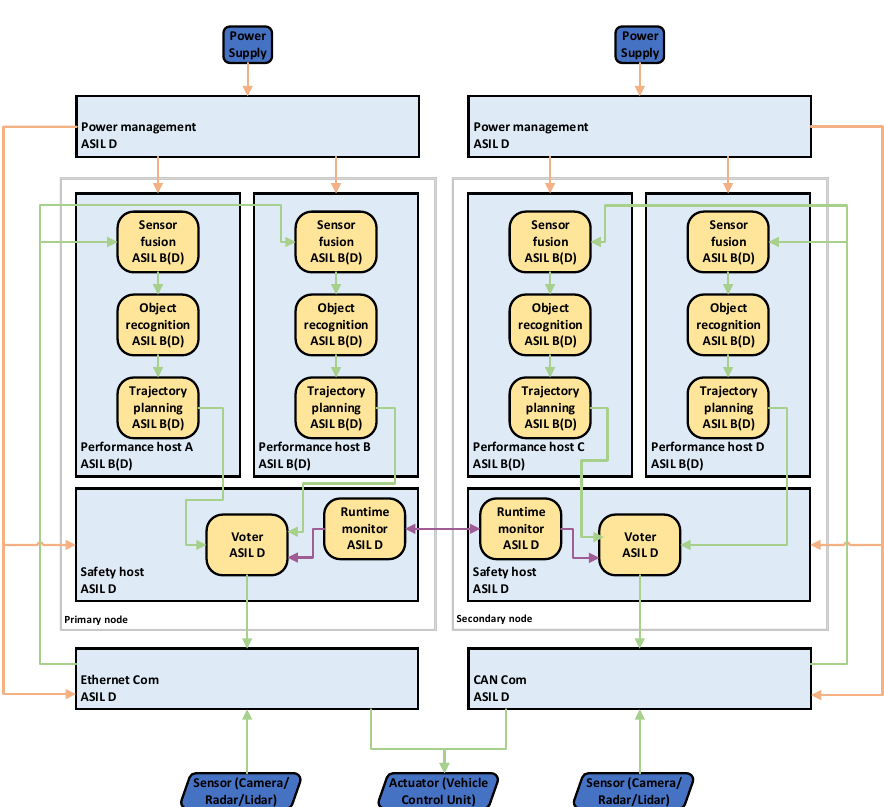
Figure 2. Simplex architecture.